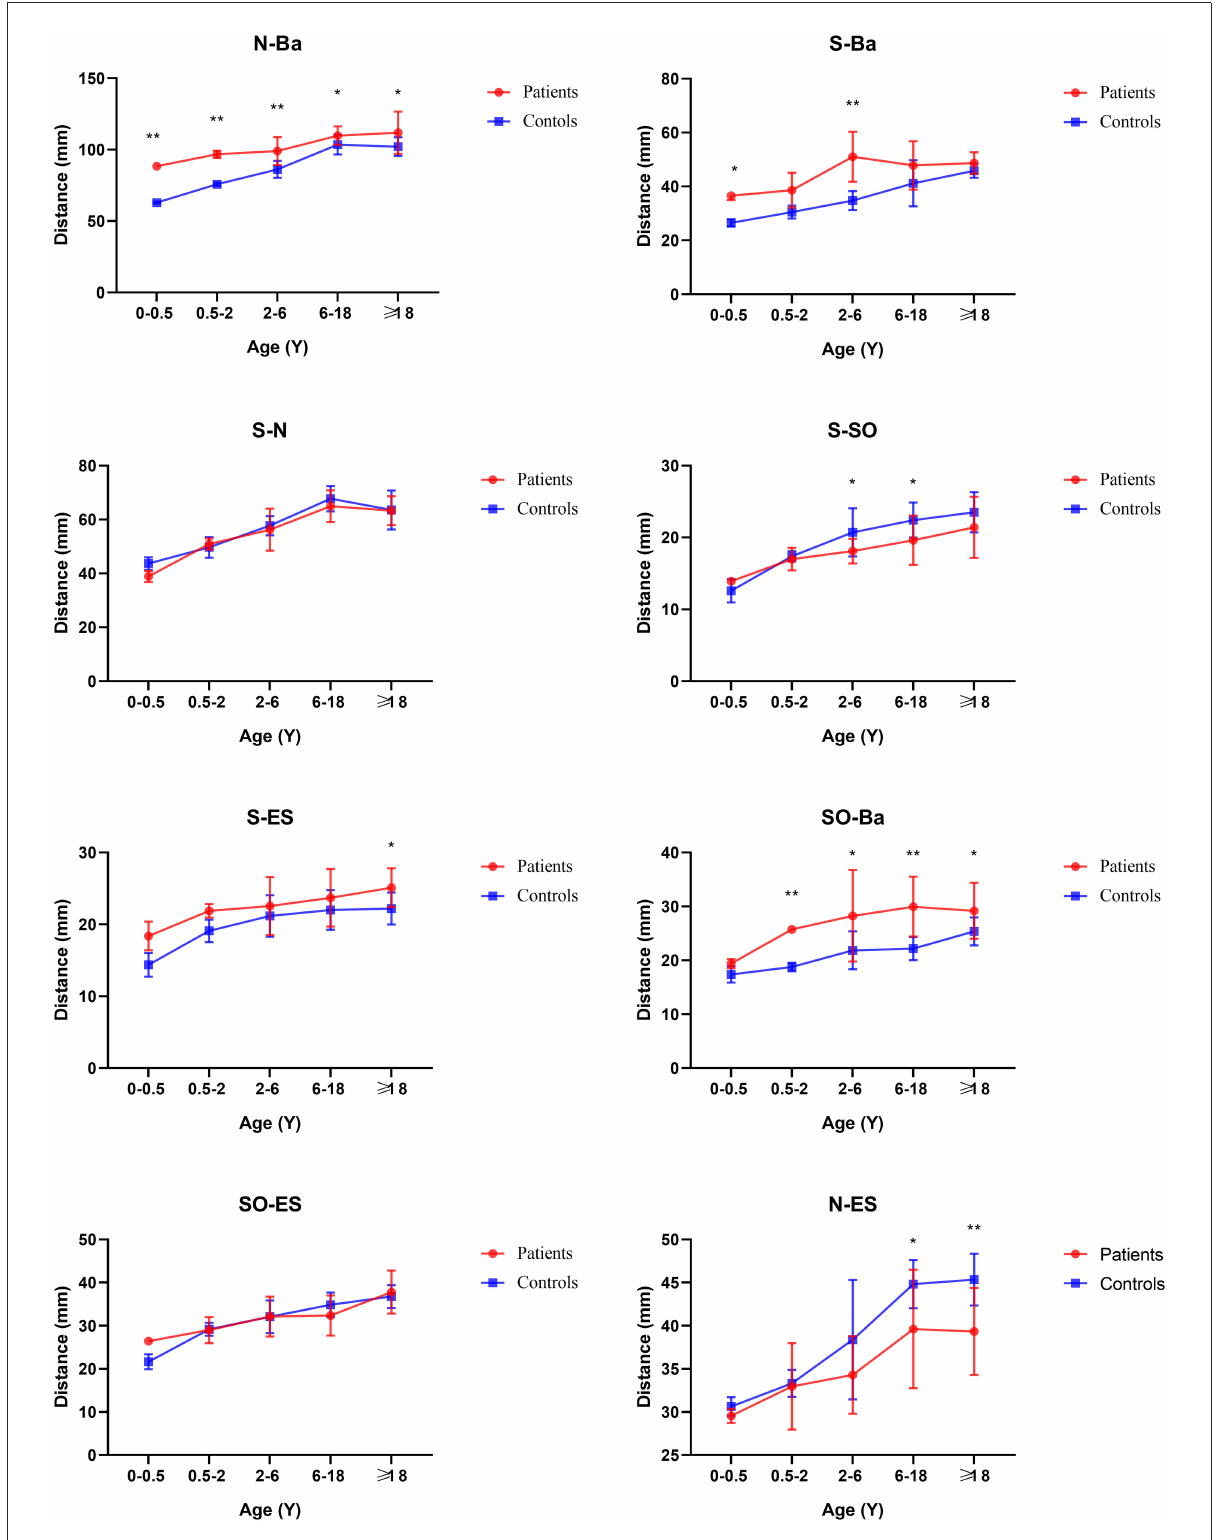
FIGURE5 Cranial base inner linear measurements by subgroup analysis. * P < 0.05; ** P <